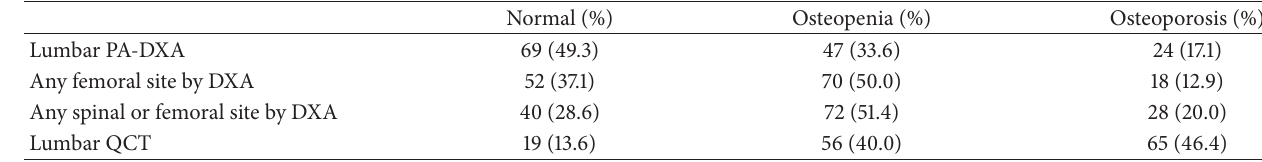
Table 1: Diagnostic results of DXA versus QCT for 140